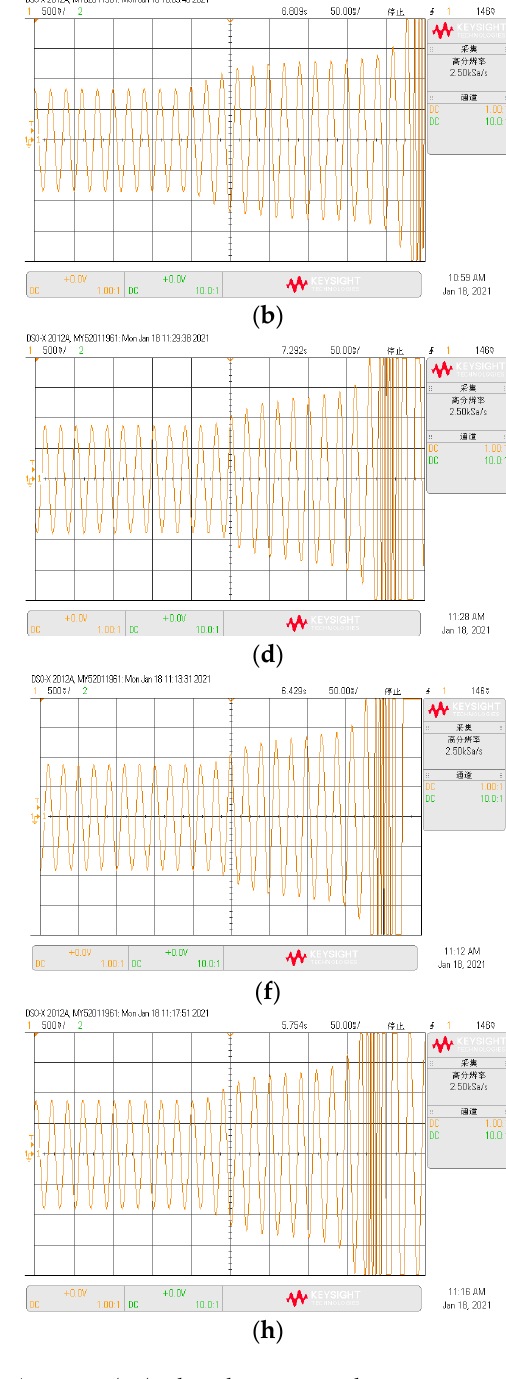
Figure 12. The responses of point of common coupling (PCC) phase A current (pu) when the remote voltage sag occurs: ( a ) The system is critically stable ( P in = 0.752 pu, SCR = 1.9, k vp = 6); ( b ) The system is unstable ( P in = 0.75 3 pu, SCR = 1.9, k vp = 6); ( c ) The system is critically stable ( P in = 0.792 pu, SCR = 2.0, k vp = 6); ( d ) The system is unstable ( P in = 0.793 pu, SCR = 2.0, k vp = 6); ( e ) The system is critically stable ( P in = 0.793 pu, SCR = 2.0, k vp = 7); ( f ) The system is unstable ( P in = 0.794 pu, SCR = 2.0, k vp = 7); ( g ) The system is critically stable ( P in = 0.794 pu, SCR = 2.0, k vp = 9); ( h ) The system is unstable ( P in = 0.795 pu, SCR = 2.0, k vp =